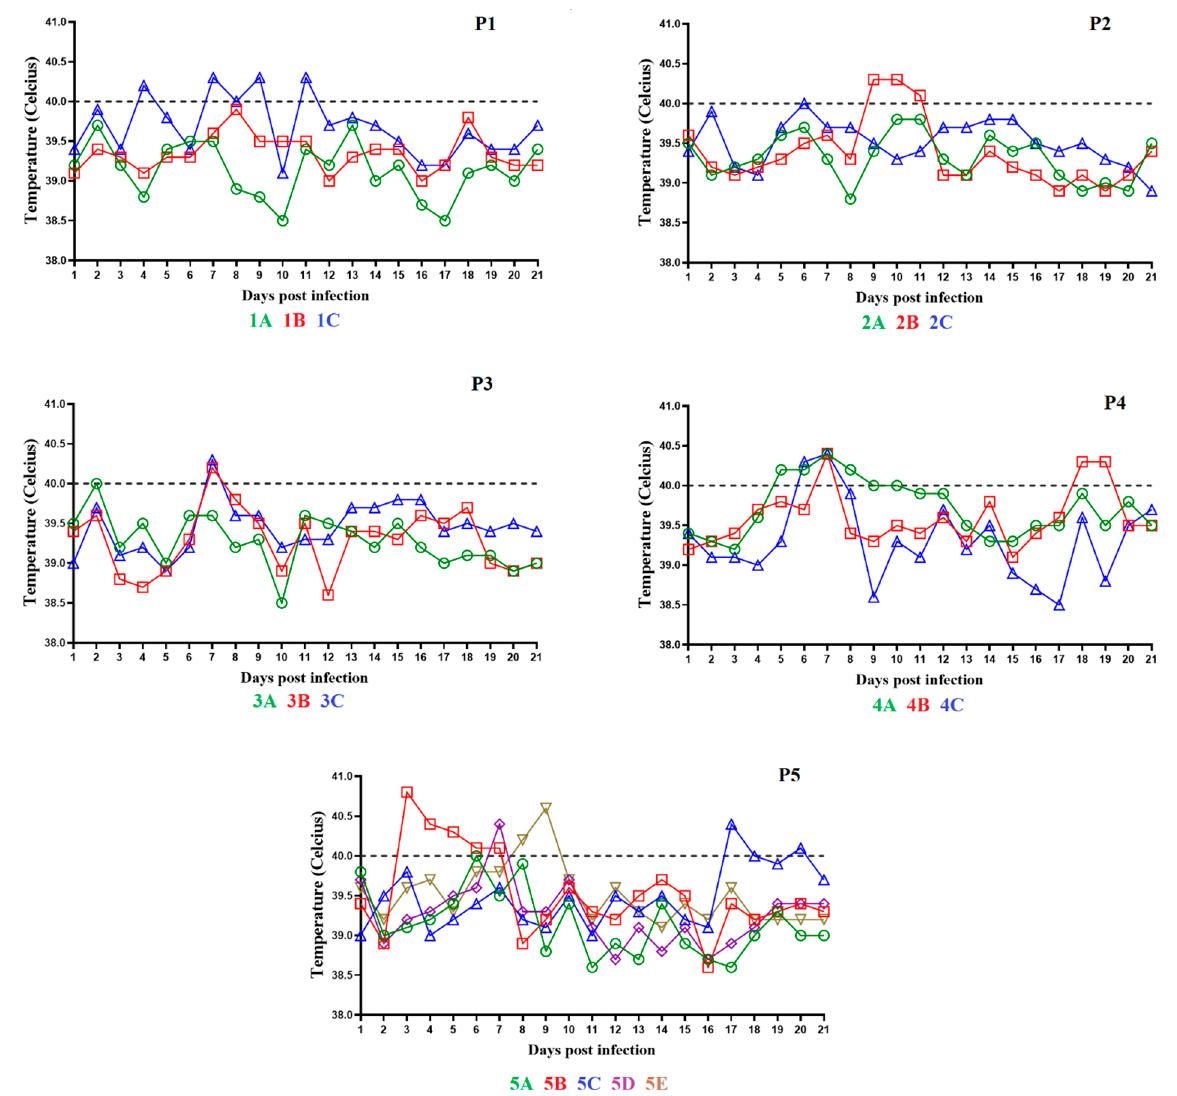
Figure 2. Evolution of body temperature in animals IM inoculated with ASFV-G- ∆ I177L during 5 consecutive passages (panels P1–P5, respectively). Data are presented as individual values (expressed as ◦ C) for each of the inoculated animals in each of the different groups.